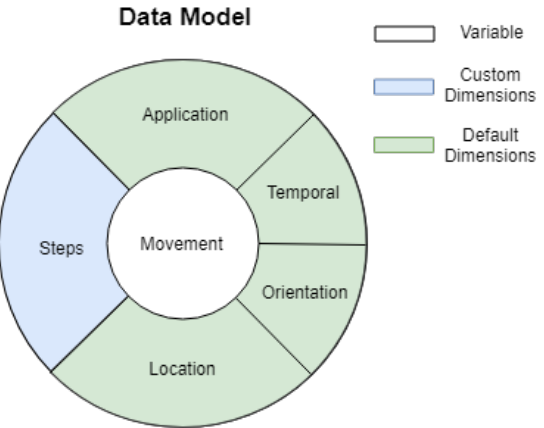
Figure 2. Representation of the relationship between the variable Movement and default and custom